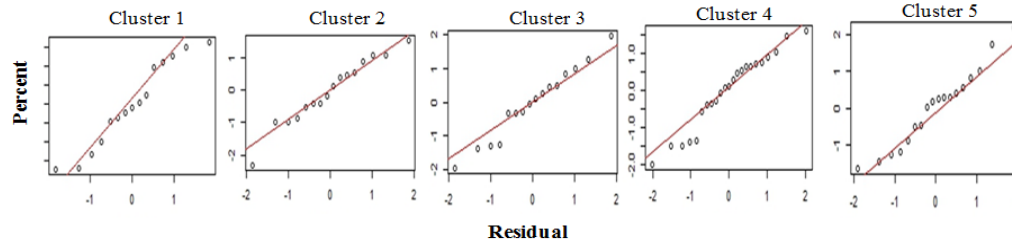
Figure 10. Normality plots for all clusters in case of 5% AEP flood.